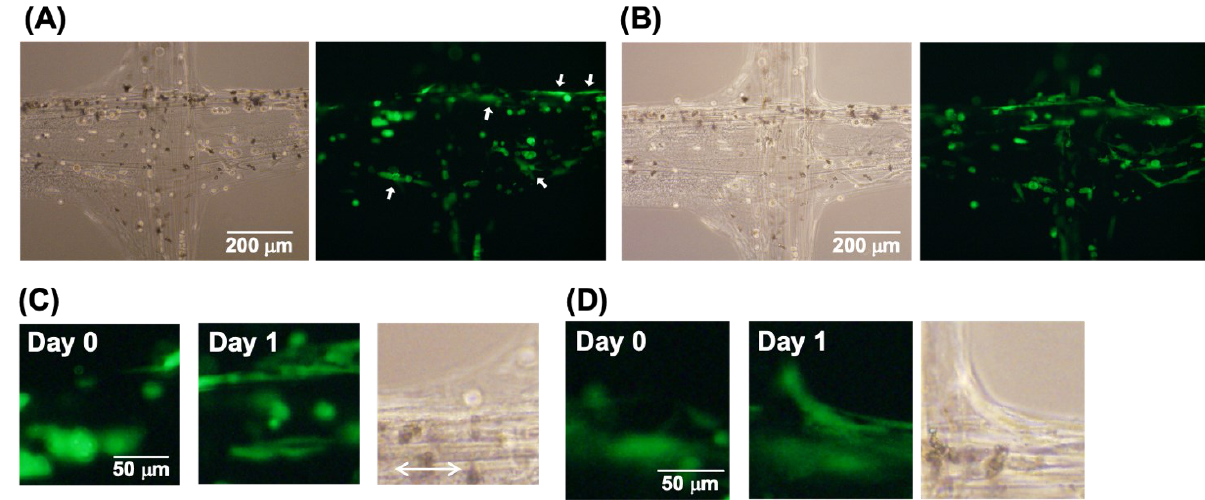
Figure 7. HUVECs embedded in hydrogel fibers after electrochemical gluing via Ca 2+ . The hydrogel fibers were cultured in Matrigel. Phase-contrast and fluorescence images of the HUVECs after ( A ) 0 and ( B ) 1 day. White arrows in ( A ) indicate cell adhesion. ( C ) Magnified fluorescence images after day 0 and day 1. An arrow indicates the direction of the hydrogel fibers. ( D ) Magnified fluorescence images at the crossing point after day 0 and day 1.